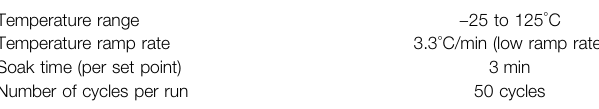
TABLE 3| Parametersofthermalreliabilitytesting (rapid thermalcyclingmachine). Temperature range